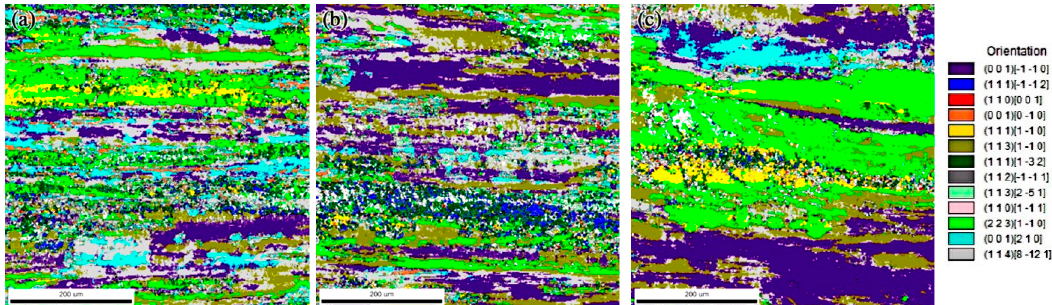
Figure 1. Orientation maps of single stage cold rolling with different slab heating temperatures: ( a ) 1170 °C, ( b ) 1220 °C, ( c ) 1270 °C.